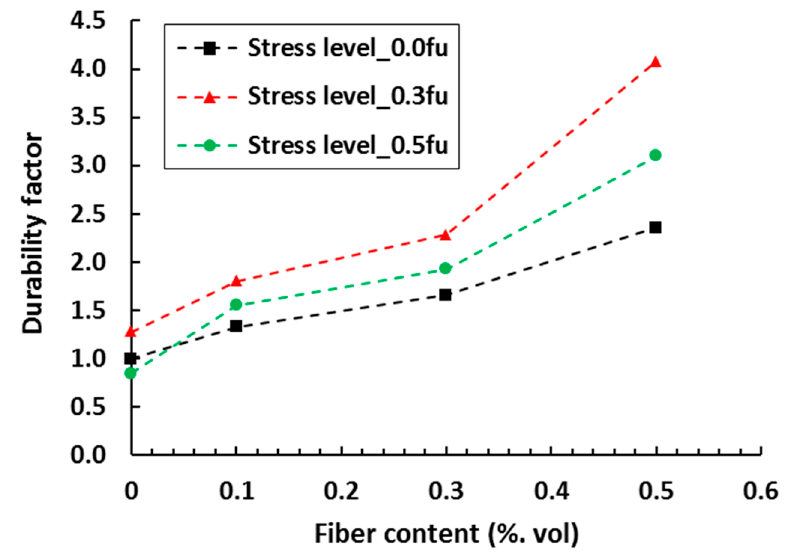
Figure 9. Influence of fiber content and stress level on the durability factor of plain and FRC specimens. Here f u represent the ultimate compressive strength of concrete (adapted from [130] ).